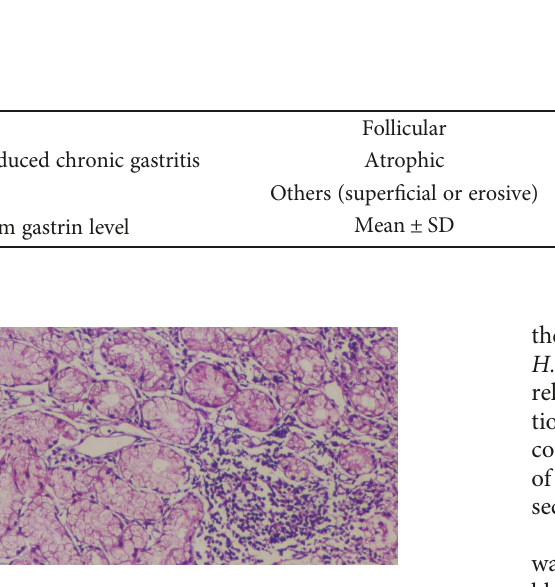
Figure 1: Histopathological pattern of follicular gastritis.